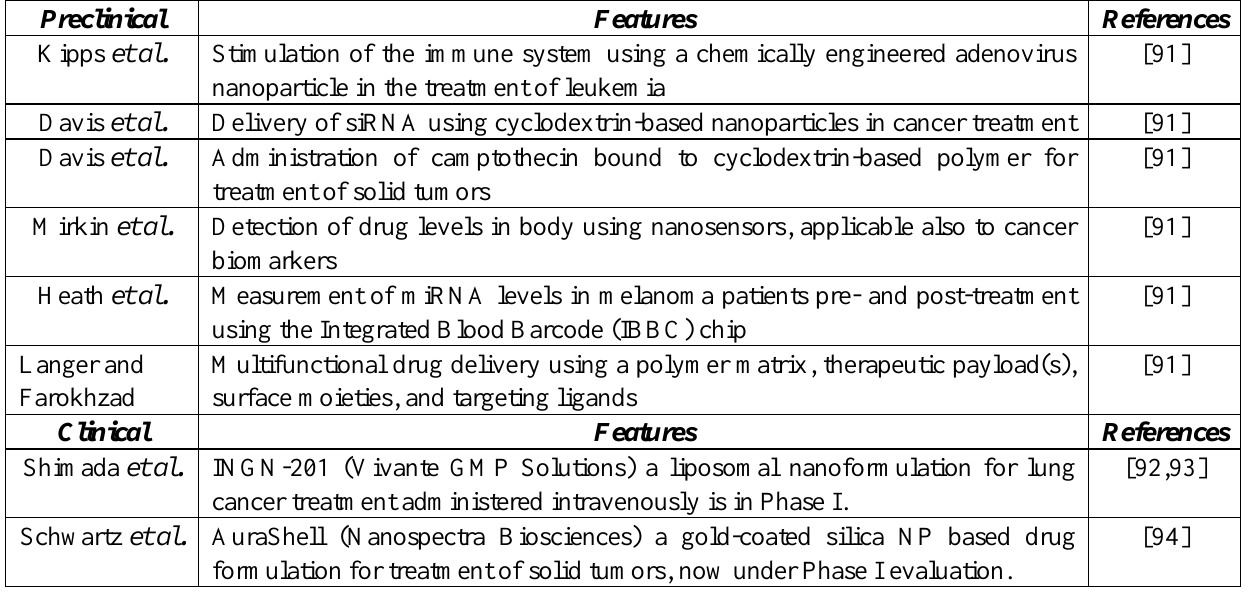
Table 2. Nanoformulations in preclinical and clinical